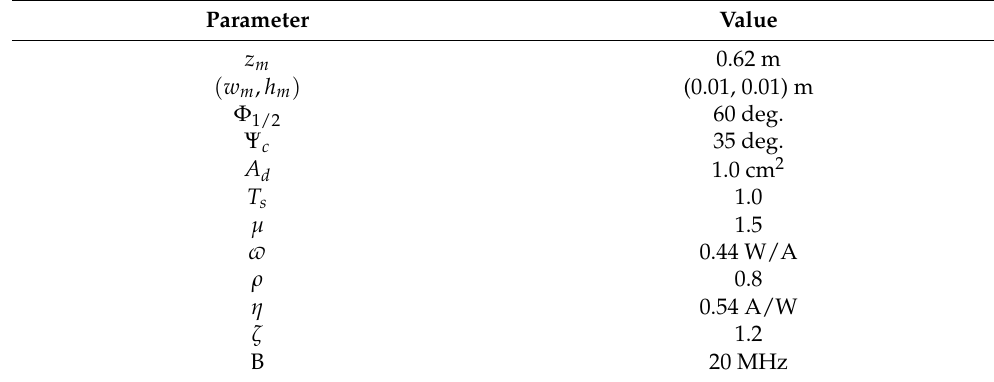
Table 2. Main simulation parameters.